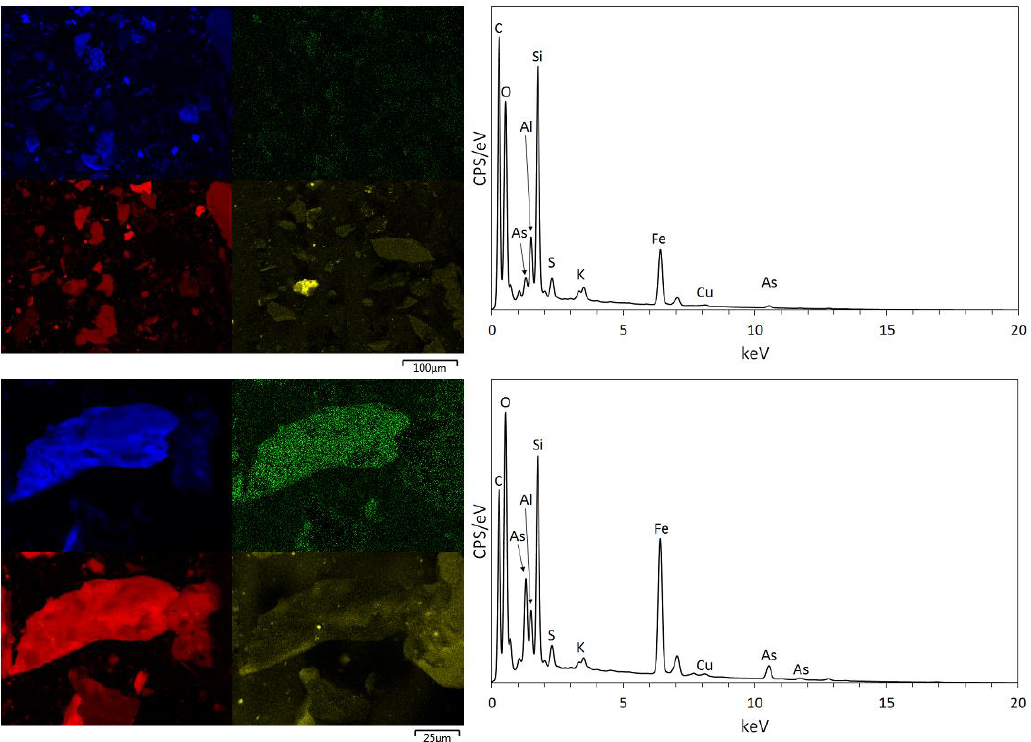
Figure 2. SEM-EDX maps for As (blue), Cu (green), Fe (yellow), and S (red) for the mine tailings along with corresponding spectra for CPS/eV detected for each element within the detection range of 0 – 20 keV.